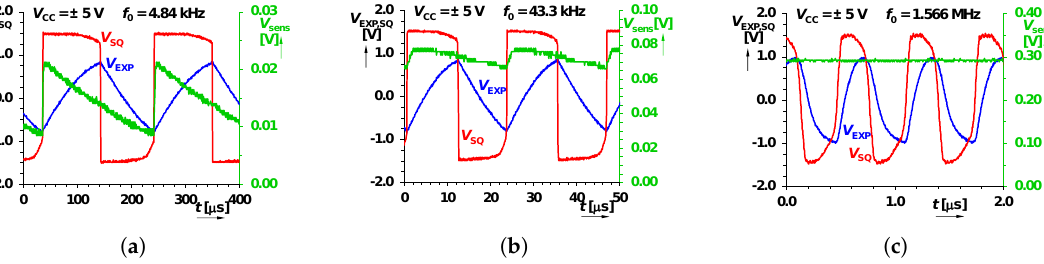
Figure 12. Snapshots of the time domain behavior of the proposed design: ( a ) C sens = 100nF ( f 0 = 4.84 kHz, V sens = 21mV); ( b ) C sens = 10nF ( f 0 = 43.3kHz, V sens = 78 mV); ( c ) C sens = 100pF ( f 0 = 1 566kHz, V sens =